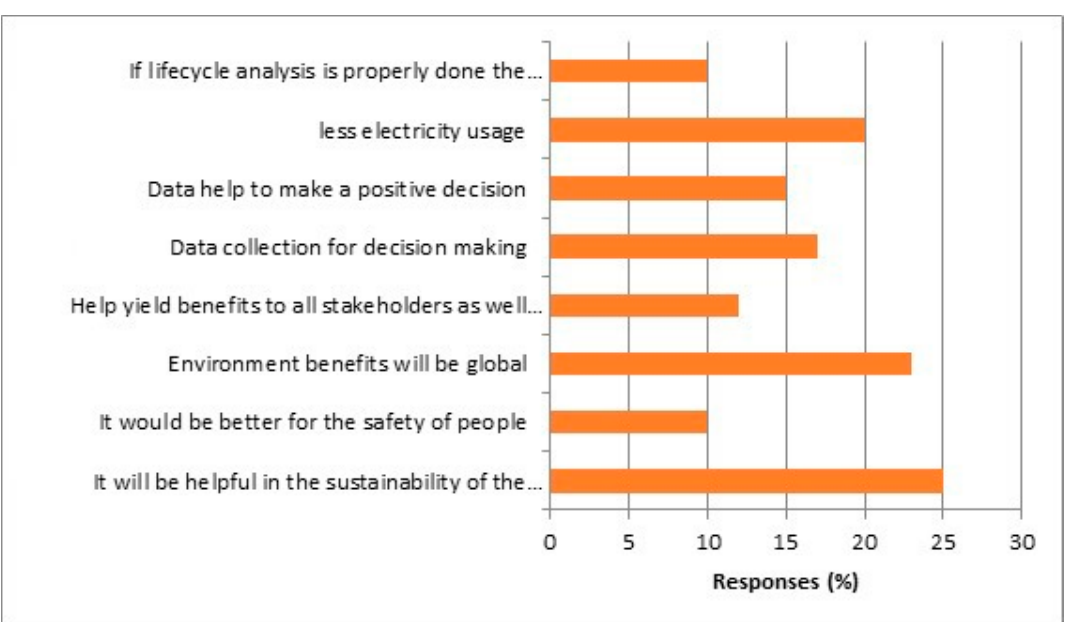
Figure 5. Importance of lifecycle adoption in the rating tool responses summarized.